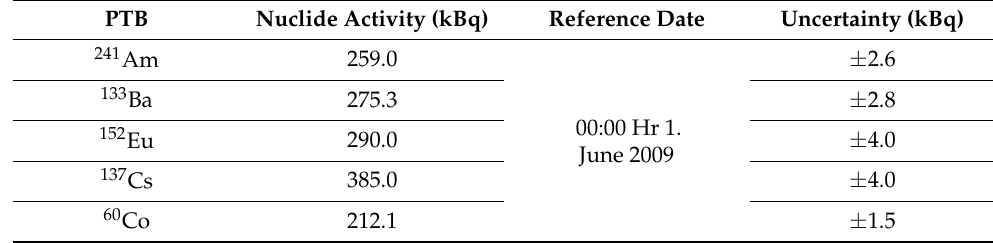
Table 3. PTB point source activities and their